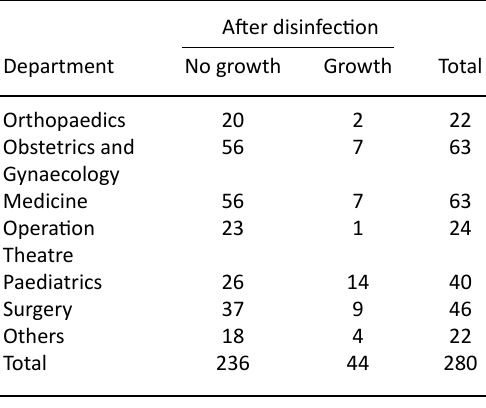
Table 4. Microbial growth after disinfection in various departments After